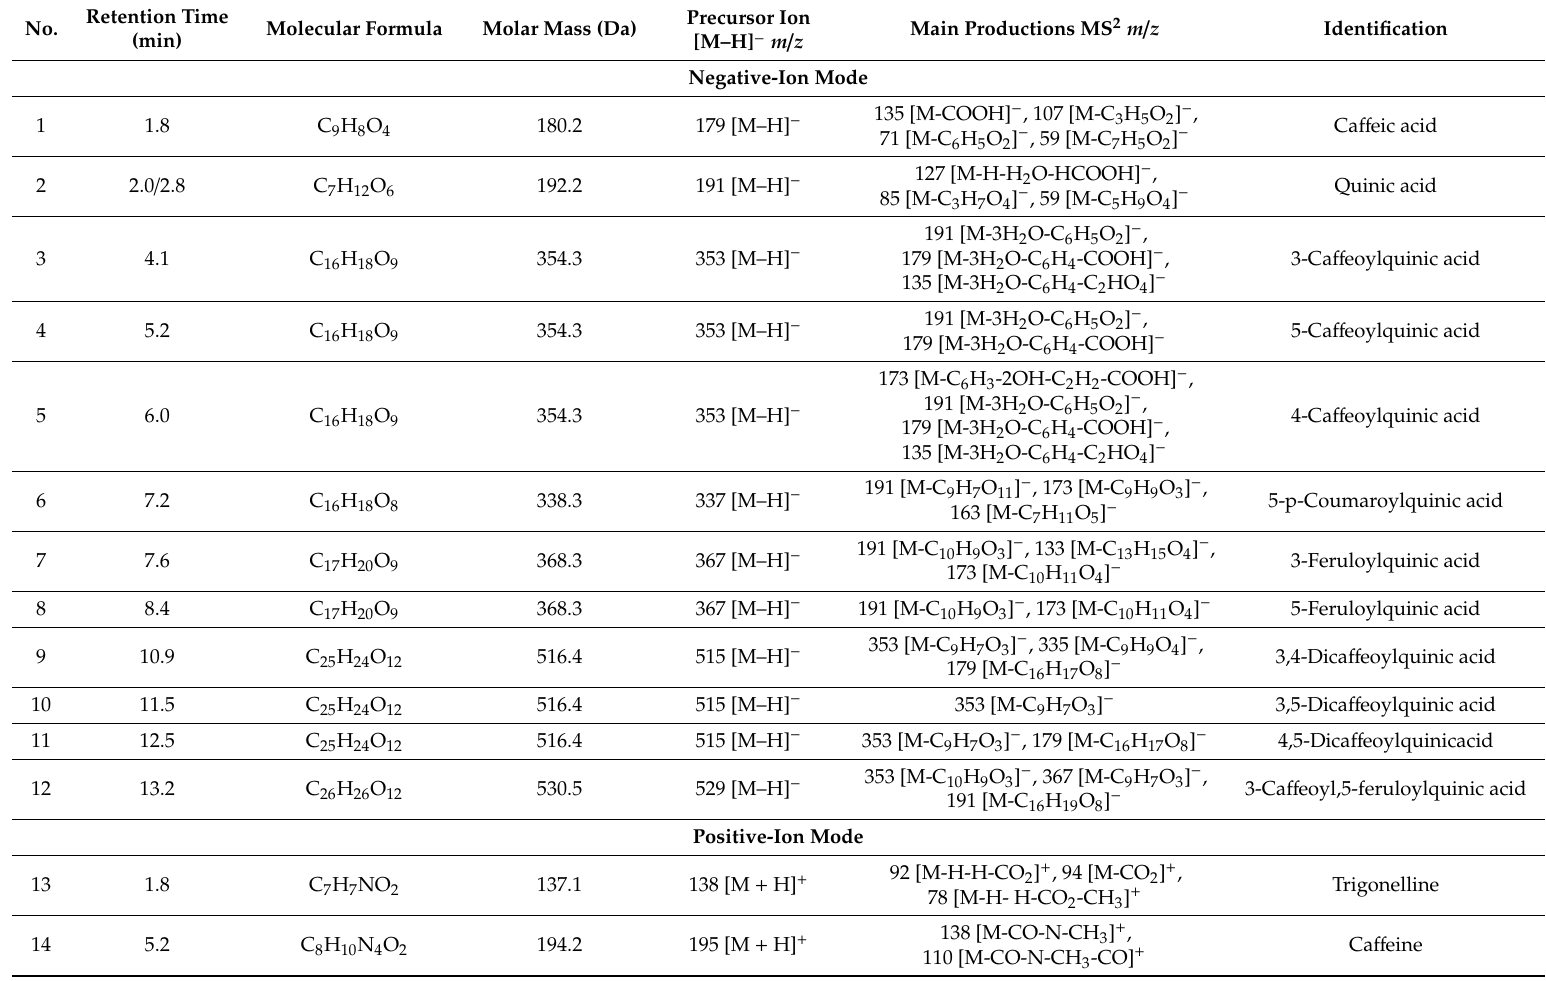
Table 2. Polyphenols detected using